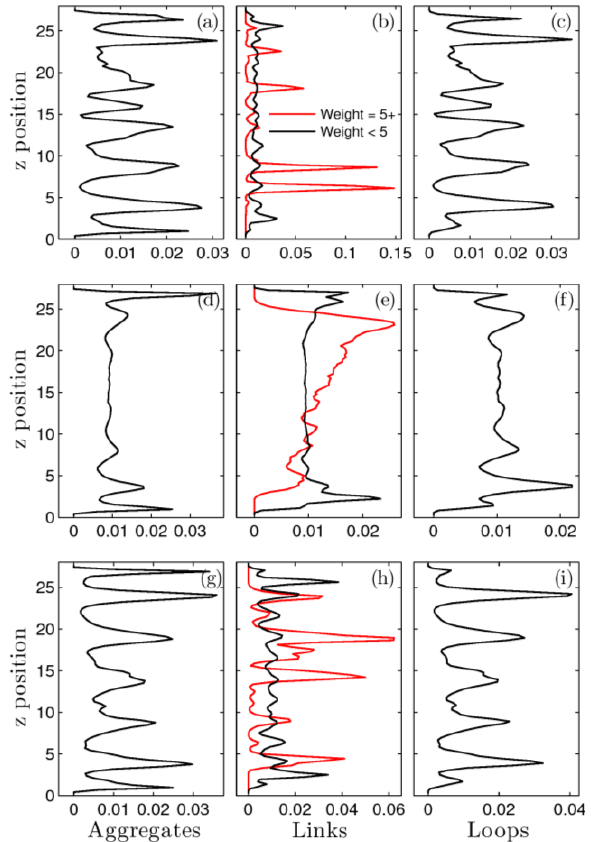
Figure 4. Topological features for ( a – c ) system at rest; ( d – f ) 𝜔 = 6.28 × 10 −4 , γ 0 = 3.59; and ( g – i ) 𝜔 = 6.28 × 10 −3 , γ 0 = 0.36 . The position of aggregates, links, and loops is shown as a probability distribution as a function of the distance (z) to the bottom of the film. Values are averaged over many oscillatory cycles. Link data are split in those for links less than weight five (black) and those for weight five and higher